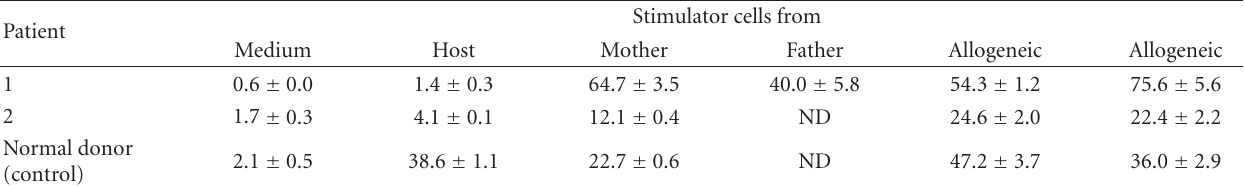
Table 2: Proliferative response of PBL from 2 patients and a normal donor to host, parental, and allogeneic cells. Patient